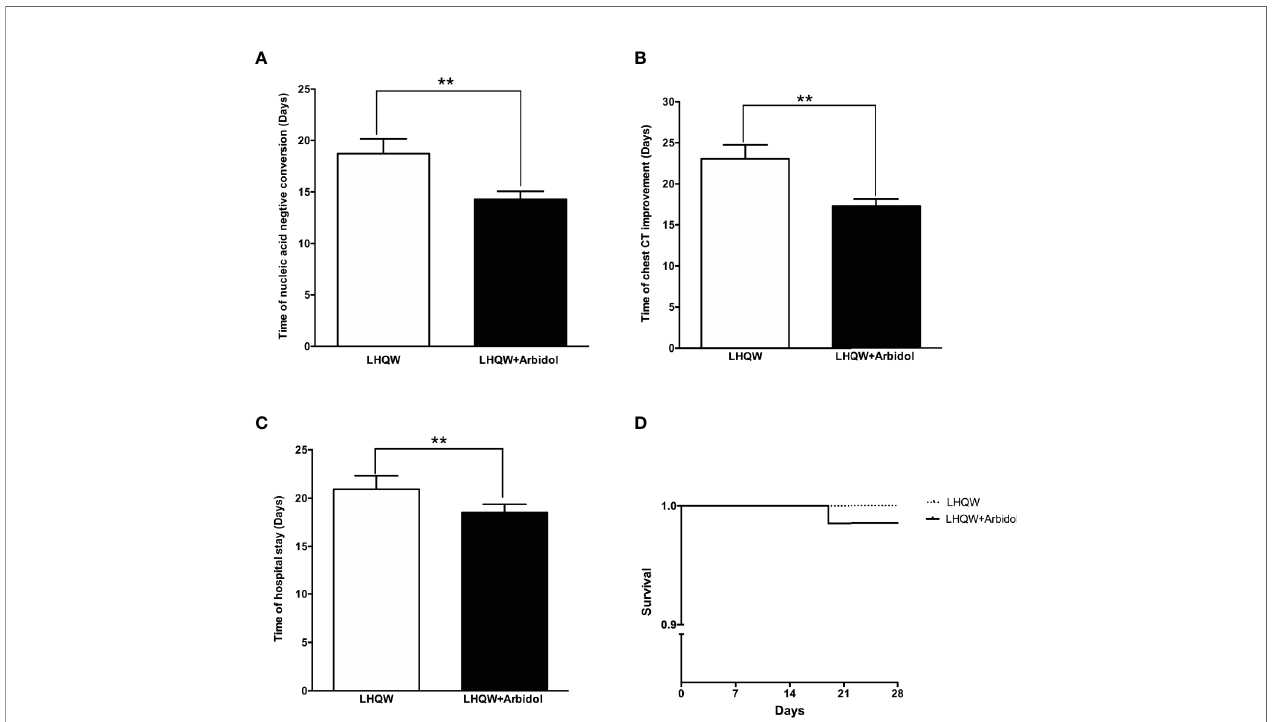
FIGURE 4 | Ef fi cacy of LHQW and LHQW+ Arbidol treatment in patients with moderate COVID-19. (A) Effect on the time to conversion to nucleic acid negativity. (B) Effect on time to chest CT improvement. (C) Effect on length of hospital stay. (D) Comparison of Kaplan – Meier survival curves between patients with moderate COVID-19 treated with LHQW and LHQW + Arbidol. **P <